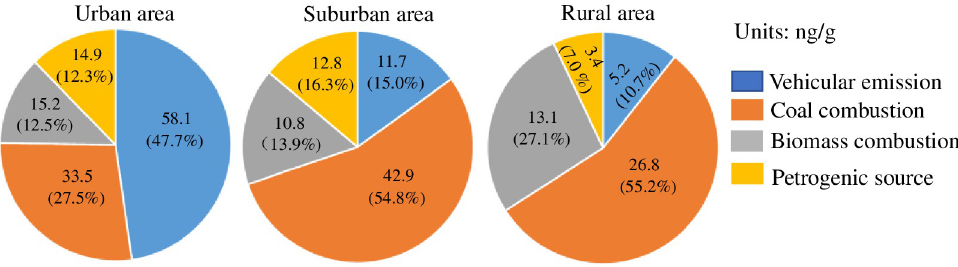
Fig 3. Source contributions to BaP TEQ for PAHs in urban soils (a), suburban soils (b) and rural soils